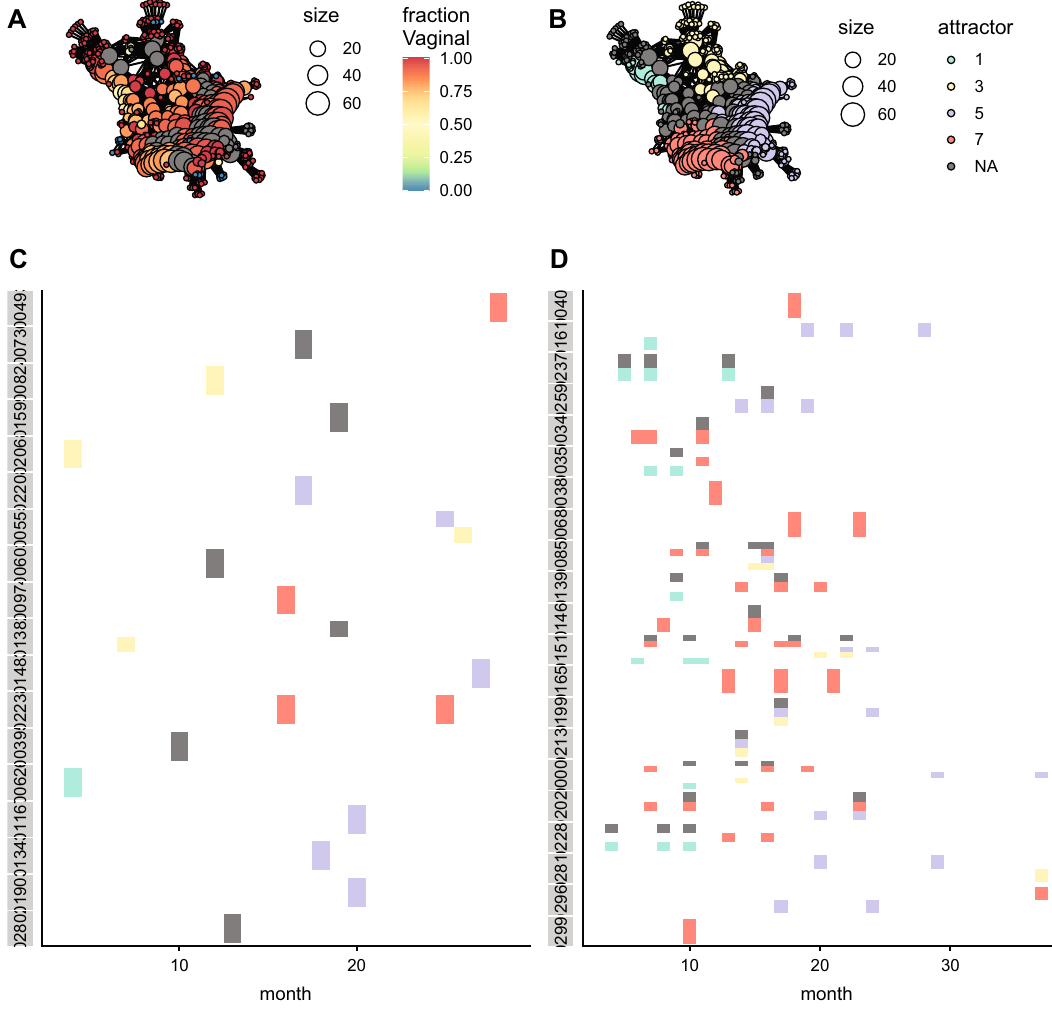
Figure 4. Ecological succession of human microbiota communities in a functional phase space, using the GO annotation. ( A ) Mapper representation of the samples. The colour represents the fraction of samples from individuals born vaginally, instead of caesarean section. ( B ) Partition of the mapper network into metastable states. Each colour corresponds to an attractor. ( C , D ) Attractor occupied per individual and month. Each row corresponds to a single individual. The colours correspond to the attractors in ( B ). ( C ) Individuals born vaginally. ( D ) Individuals born via caesarean